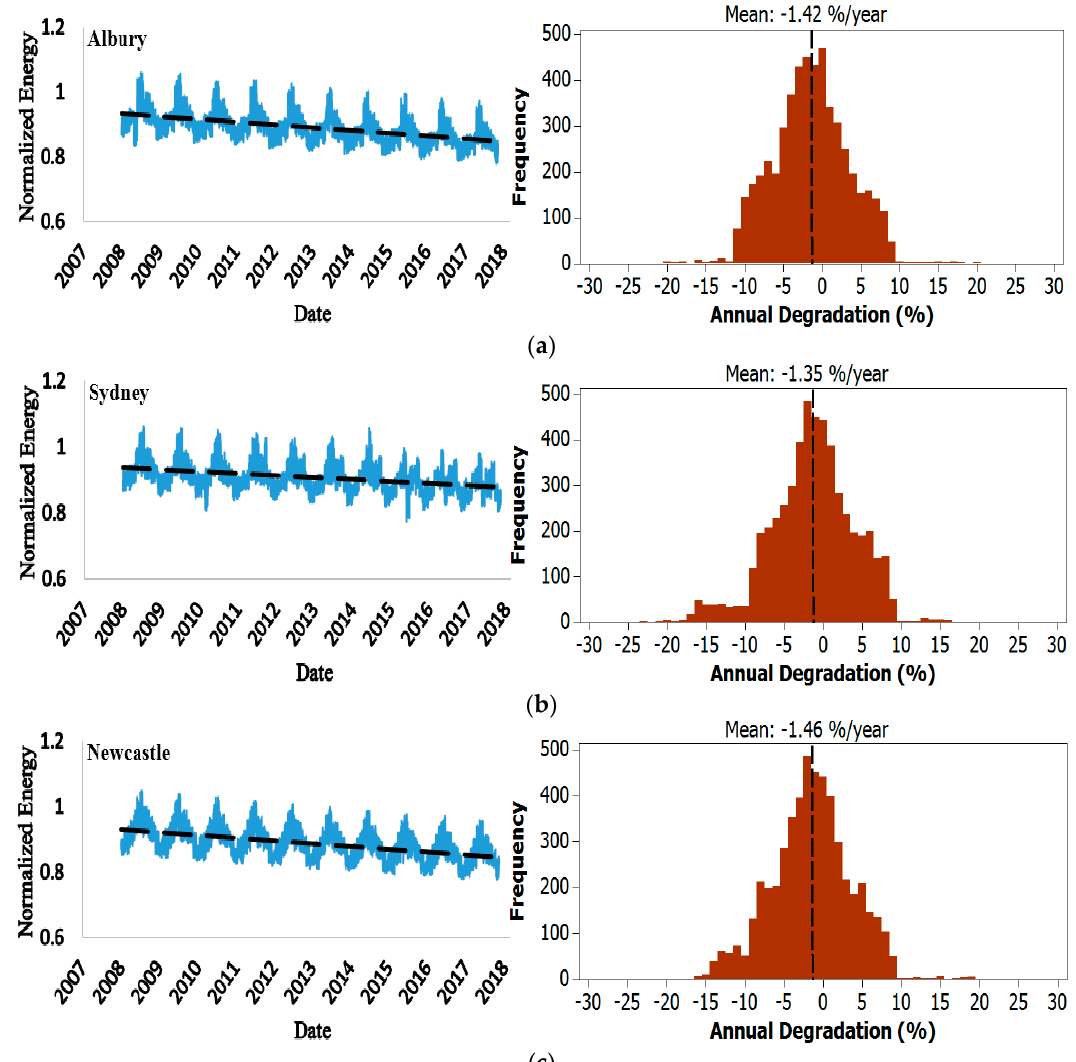
Figure 6. Normalized energy and annual degradation of the examined PV systems in Australia: ( a ) PV site D—Albury; ( b ) PV site E—Sydney; ( c ) PV site F—Newcastle.